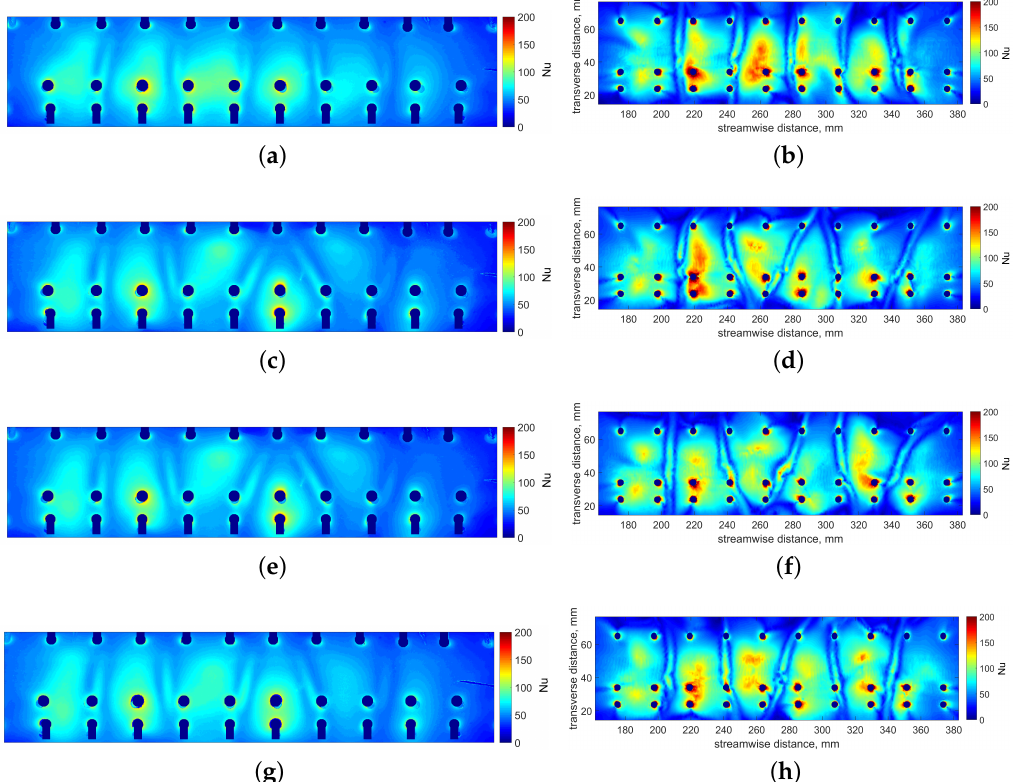
Figure 11. Comparison of measured Nusselt number distributions with CFD predictions for all geometries at Re = 17,500. ( a ) Geom 1—Exp.; ( b ) Geom 1—CFD; ( c ) Geom 2—Exp.; ( d ) Geom 2—CFD; ( e ) Geom 3—Exp.; ( f ) Geom 3—CFD; ( g ) Geom 4—Exp.; ( h ) Geom 4—CFD.